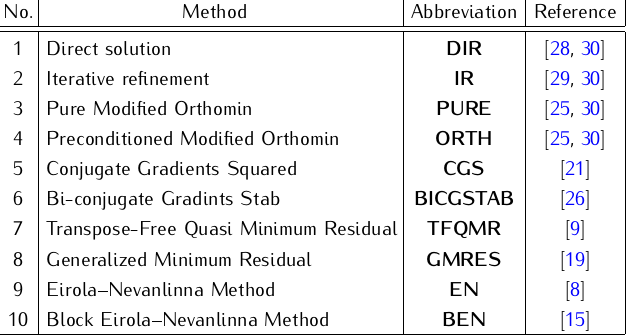
Table 1. Ten numerical methods for solving systems of linear algebraic equations.